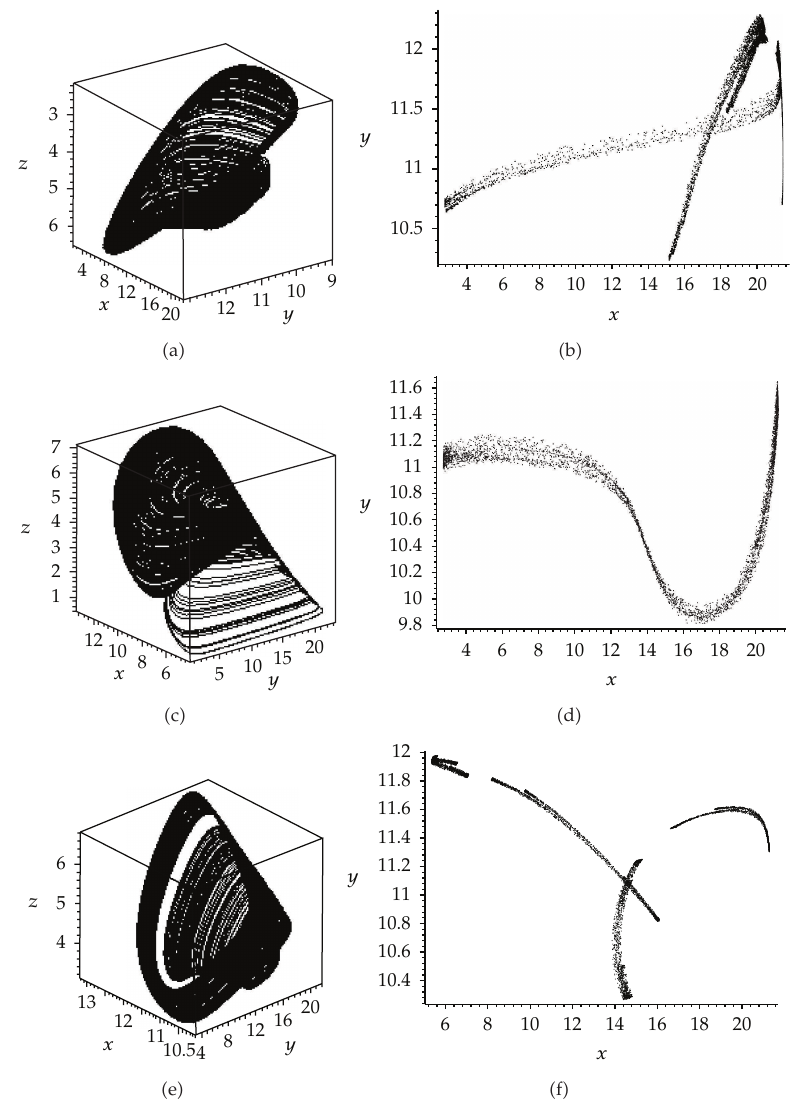
Figure 3: (cid:7) a (cid:8) Strange attractor with ϕ (cid:6) 0, k 2 (cid:6) 23; (cid:7) b (cid:8) Poincar´e section of attractor (cid:7) a (cid:8) ; (cid:7) c (cid:8) strange attractor with ϕ (cid:6) (cid:7) π/ 2 (cid:8) , k 2 (cid:6) 23; (cid:7) d (cid:8) Poincar´e section of attractor (cid:7) c (cid:8) ; (cid:7) e (cid:8) strange attractor ϕ (cid:6) π , k 2 (cid:6) 23; (cid:7) f (cid:8) Poincar´e section of attractor (cid:7) e (cid:8) , showing the values of the states x and y in the plane z (cid:6)